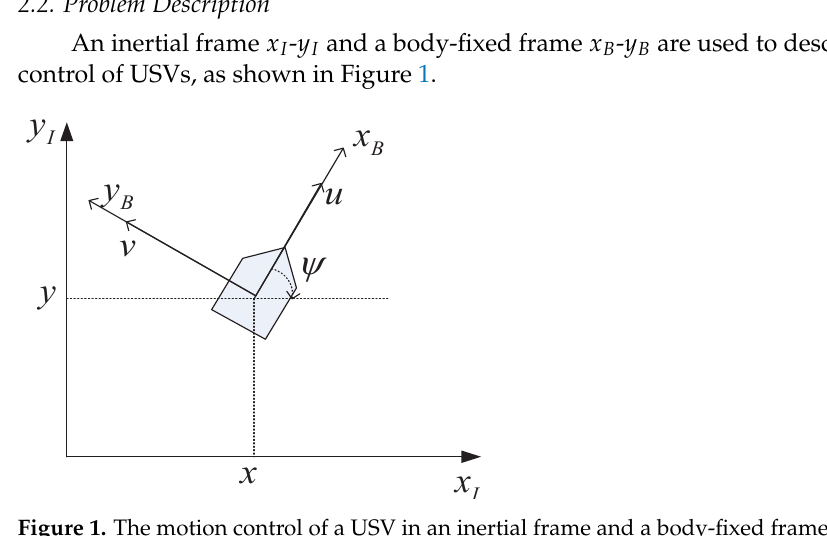
Figure 1. The motion control of a USV in an inertial frame and a body-fixed